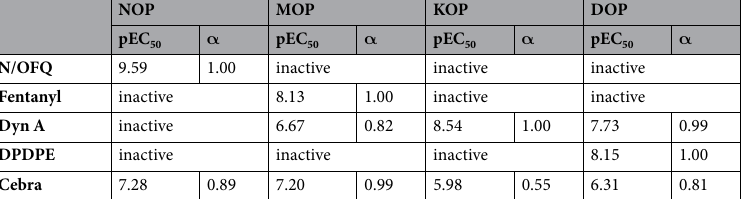
Table 1. Pharmacological profile of Cebranopadol (Cebra) in cells coexpressing human recombinant NOP or classical opioid receptors and chimeric G